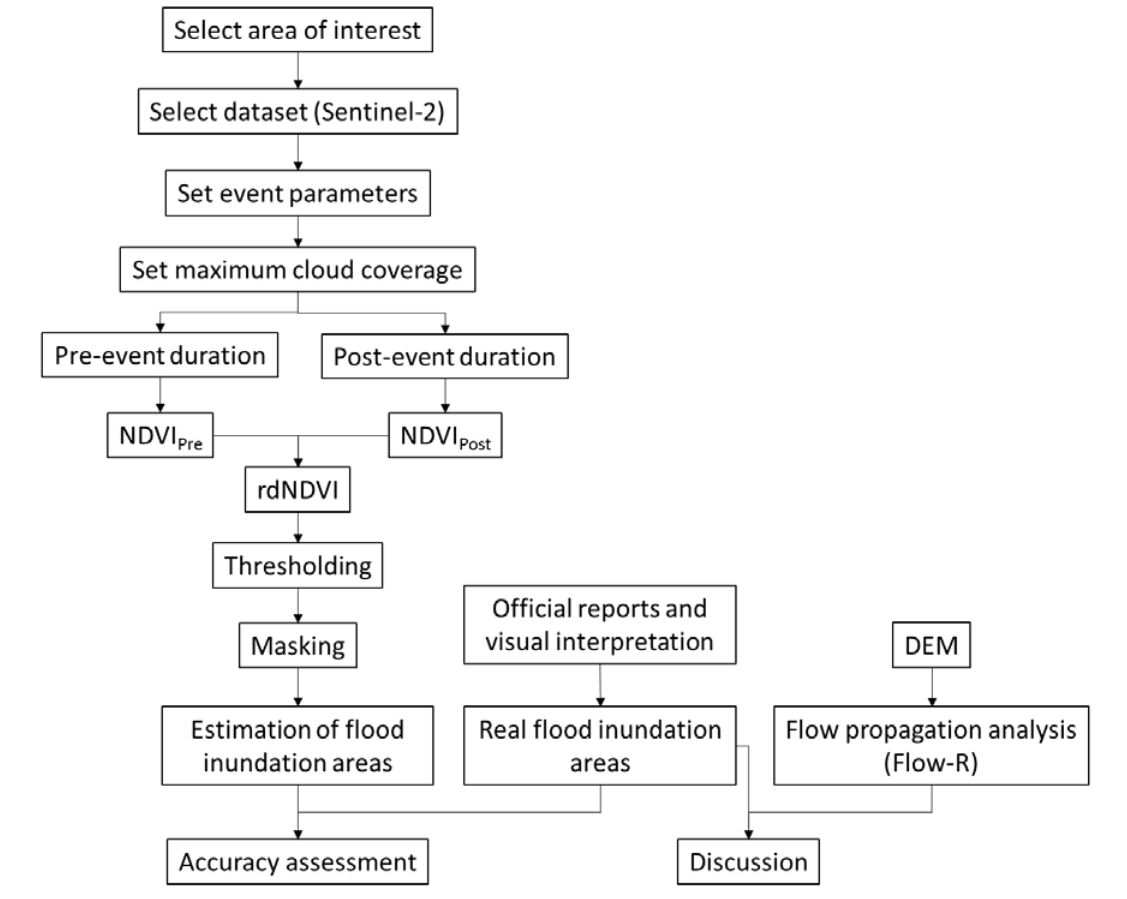
Figure 4. Flowchart of the methodology used in this study.